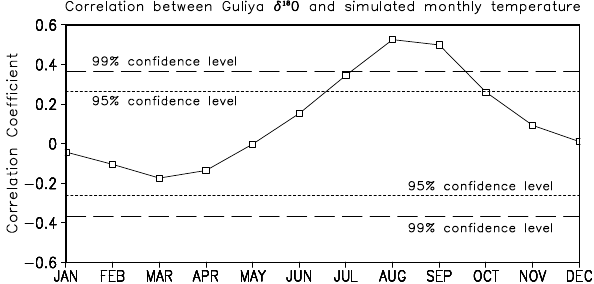
Fig. 3 . Time series of the simulated Guliya August–September SAT (red line, left Fig. 3. Time series of the simulated Guliya August–September SAT ordinate) and the Guliya δ 18 O - temperature proxy record (green line, right (red line; left ordinate) and the Guliya δ 18 O-temperature proxy record (green line; right ordinate). The correlation coefficient ( R ) ordinate). The correlation coefficient (R) between them is 0.55, significant at the between them is 0.55, significant at the 99.9% confidence 99.9% confidence level.